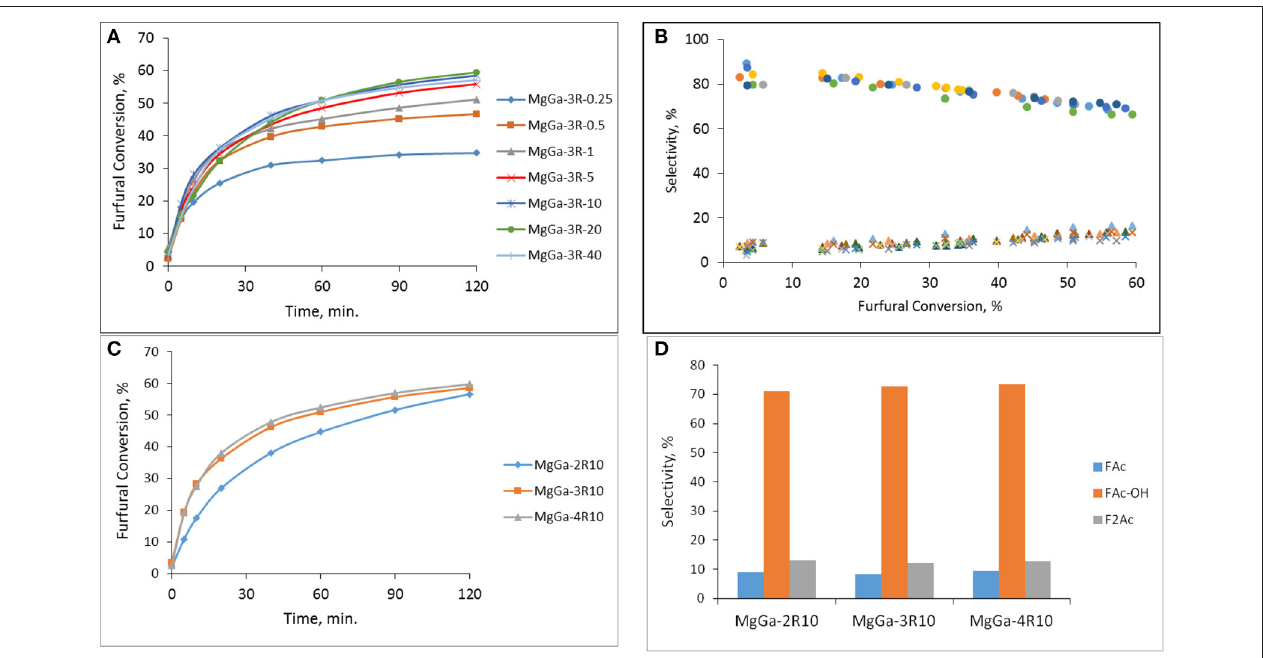
FIGURE 12 | (A) The change in furfural conversion in the course of experiment observed on MgGa-3R samples prepared by different rehydration time. (B) The dependence of product selectivity on furfural conversion observed on MgGa-3R-X catalysts ( • – FAc-OH, 1 - FAc, x – F 2 Ac). (C) Influence of Mg/Ga in reconstructed MgGaXR-10 samples on furfural conversion. (D) Influence of Mg/Ga in reconstructed MgGaXR-10 samples on product selectivity at furfural conversion ≈ 30%. T = 25 ◦ C, molar ratio Ac/F =